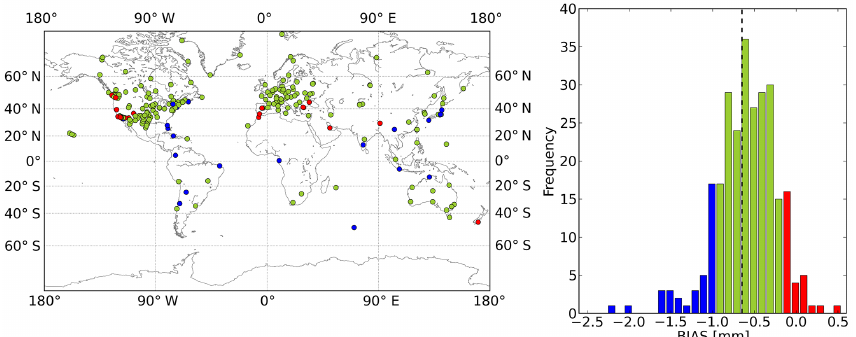
Figure 10. Bias for each station between the TCWV observed at 10:30LT and the daily mean TCVW for all cases, that were cloud-free at 10:30 local time. Right plot: histogram of the bias, blue bars indicate the classes that are in the 10th percentile, red bars indicate classes that are above the 90th percentile; the vertical dashed line illustrates the position of the station-median bias. Left plot: spatial distribution of stations coloured with the three percentile